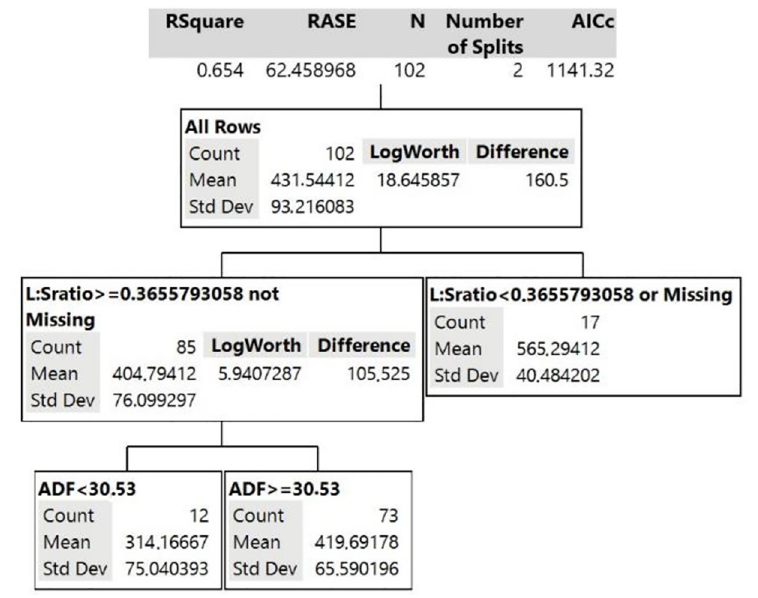
Fig 1. Decision Tree model for grazing time behavior variable of the animal grazing guinea grass (GG canopy).